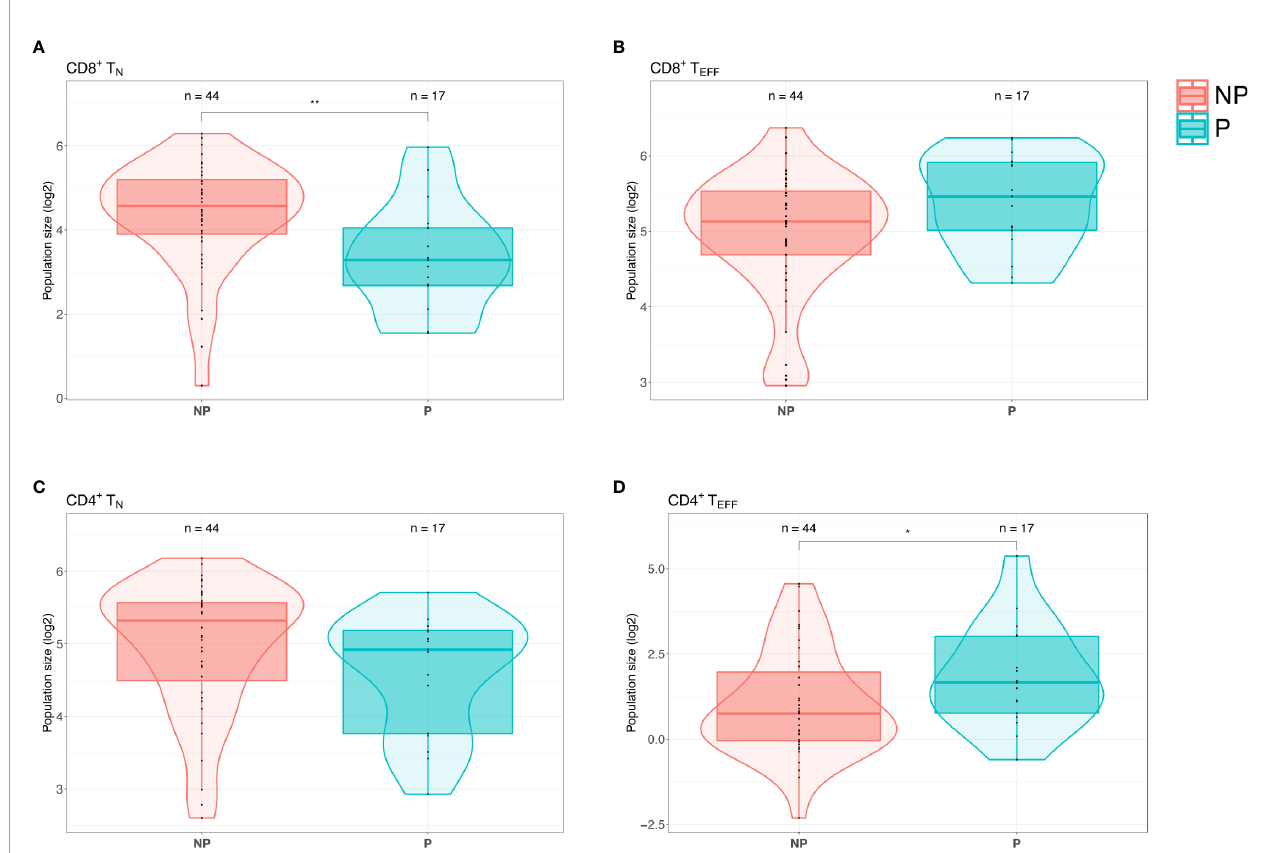
FIGURE 2 | Patients with type 1 diabetes (T1D) with complications display a shift from naïve T cells to effector T cells. (A) Flow cytometry screening of PBMCs from PROLONG patients revealed a signi fi cant decrease of CD8 + naïve T (T N ) cells (CD3 + CD4 + CD45RA + CCR7 + CCR5 - ) in progressors (P) compared to non-progressors (NP). (B) Progressors displayed elevated CD8 + effector T (T EFF ) cells (CD3 + CD4 + CD45RA + CCR7 - ) simultaneously (p = ns). (C) CD4 + T N cells were also declined in patients with T1D with complications as compared to NPs (p = ns). (D) In progressors CD4 + T EFF cells were signi fi cantly elevated compared to NPs. (For the comparison between the different groups, multiple linear regression was applied and adjusted for the age and sex covariates. *p < 0.05 and **p <